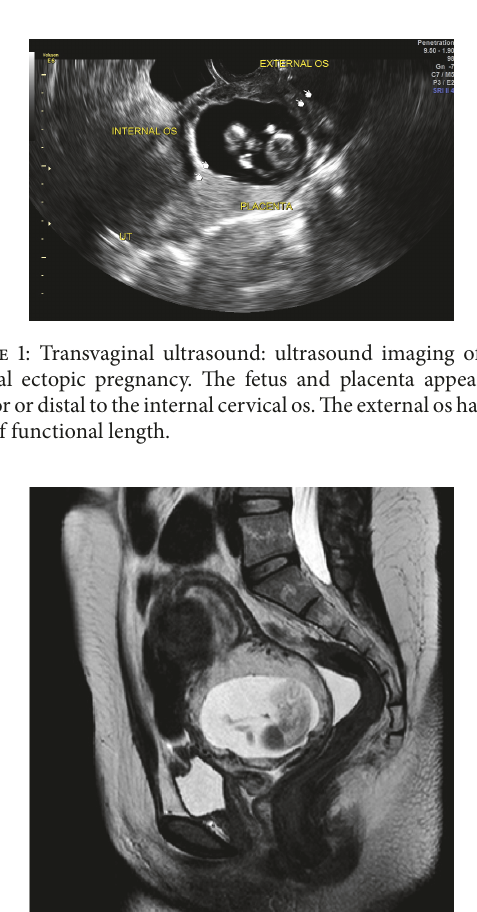
Figure 2: T2 weighted pelvic MRI: approximately 6.5 x 4.5 x 5 cm amniotic sac with embryo, centered in the